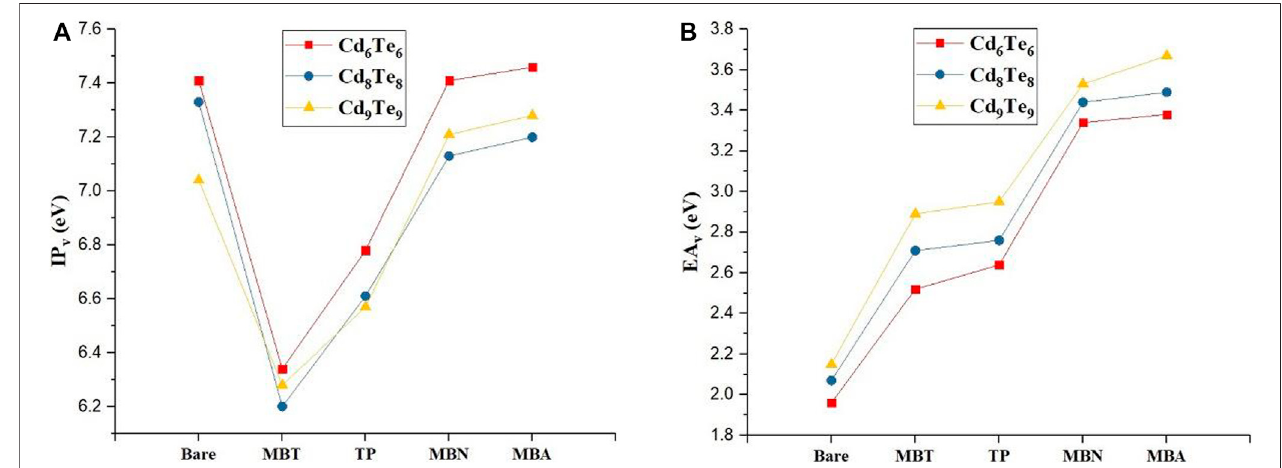
FIGURE 9 | IP v (A) and EA v (B) for bare and capped Cd n Te n L n ( n (cid:1) 6, 8, and 9)